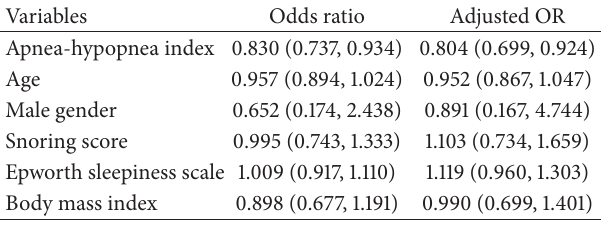
Table 3: Factors associated with having an apnea-hypopnea index (AHI) less than 5 times/hour after radiofrequency treatment in obstructive sleep apnea